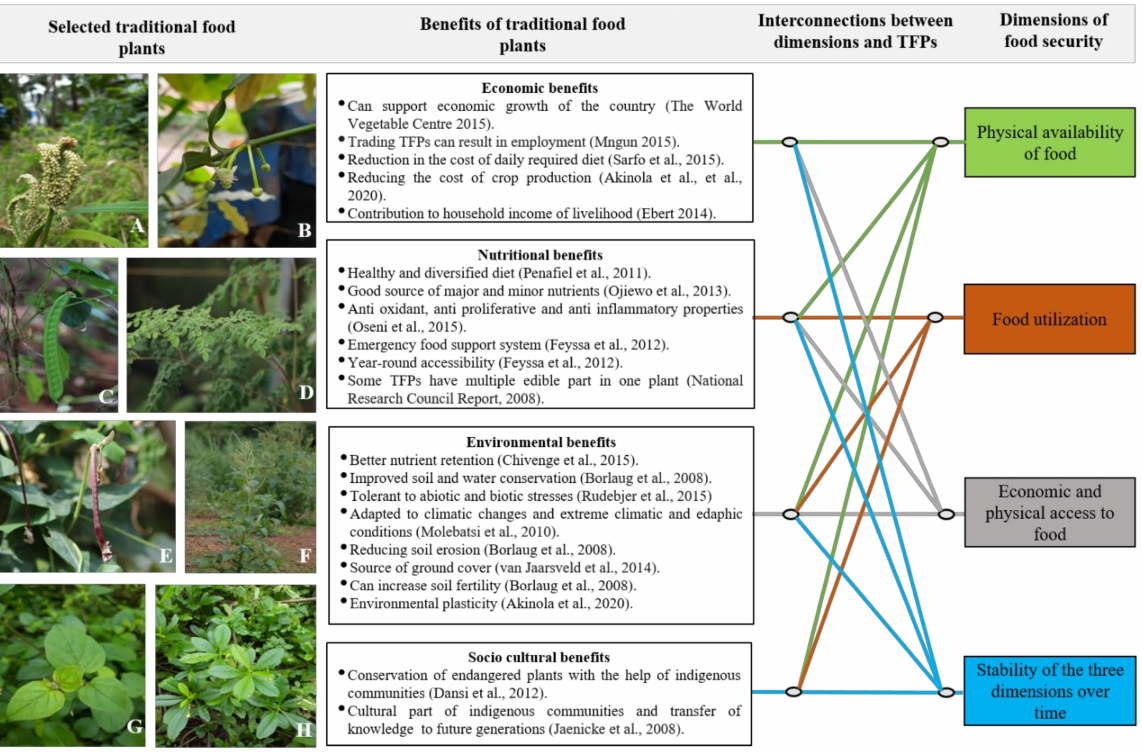
Figure 1. The congruence of traditional food plants with four dimensions of food security [44,58]. Examples of few traditional food plants: ( A ) Eleusine coracana (L.) Gaertn., ( B ) Garcinia madruno (Kunth) Hammel., ( C ) Canavalia ensiformis (L.) DC., ( D ) Moringa oleifera Lam., ( E ) Vigna unguiculata L. (Walp), ( F ) Amaranthus palmeri S. Watson, ( G ) Boerhavia diffusa L. and ( H ) Talinum triangulare